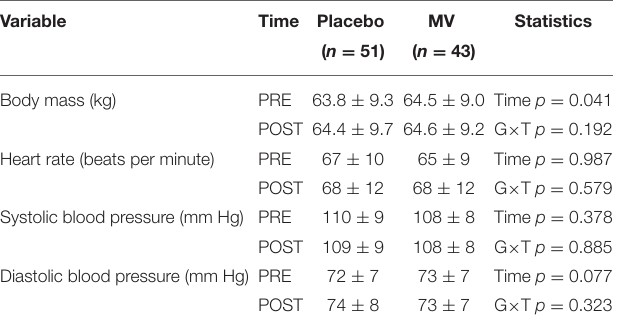
TABLE 2 | Body mass, heart rate, and blood